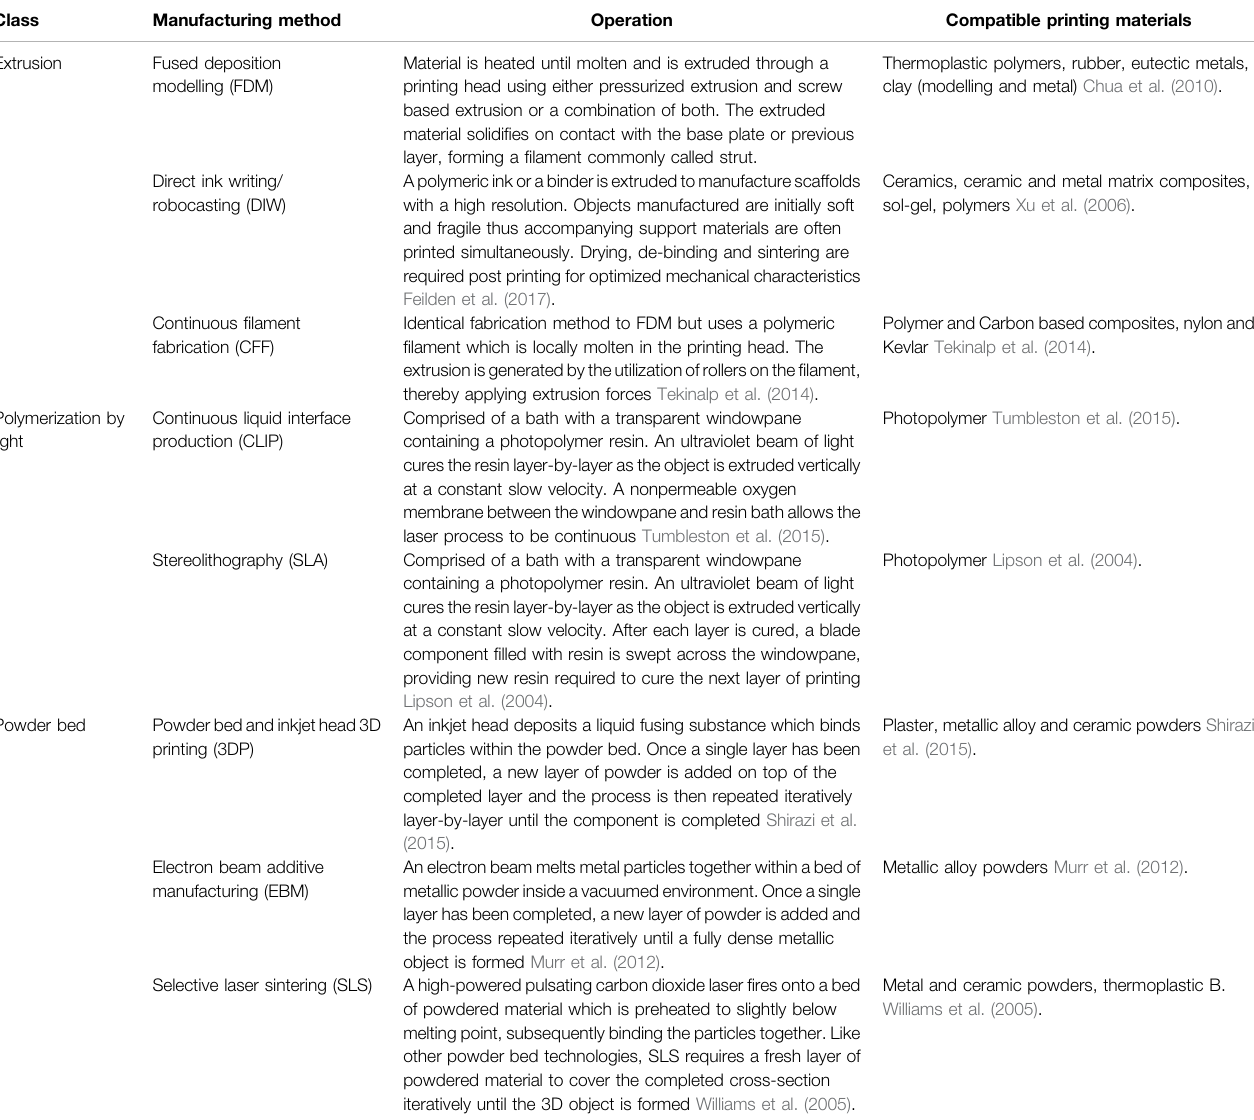
TABLE 1 | Description of the various 3D-printing